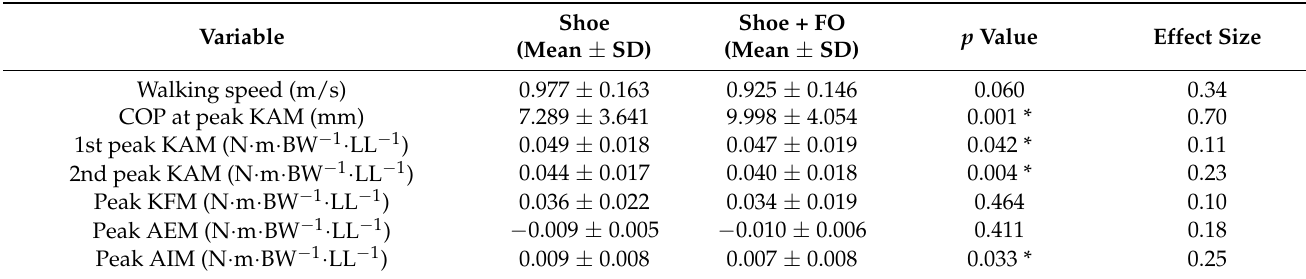
Table 1. Comparison of the walking speed and biomechanical variables between two conditions: wearing standard shoes (Shoe) and wearing shoes embedded with 3D-printed FO (Shoe +